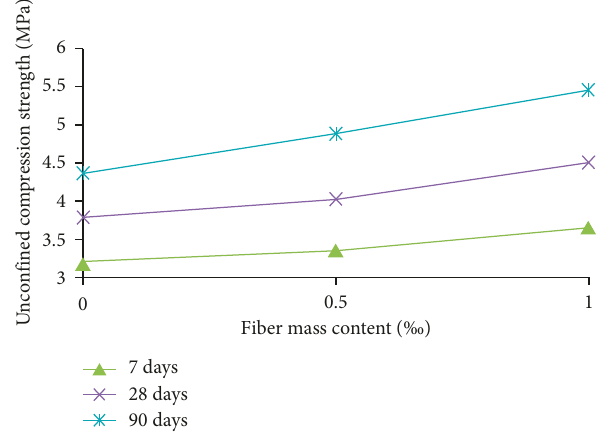
Figure 17: Influence of fiber content on compressive strength.